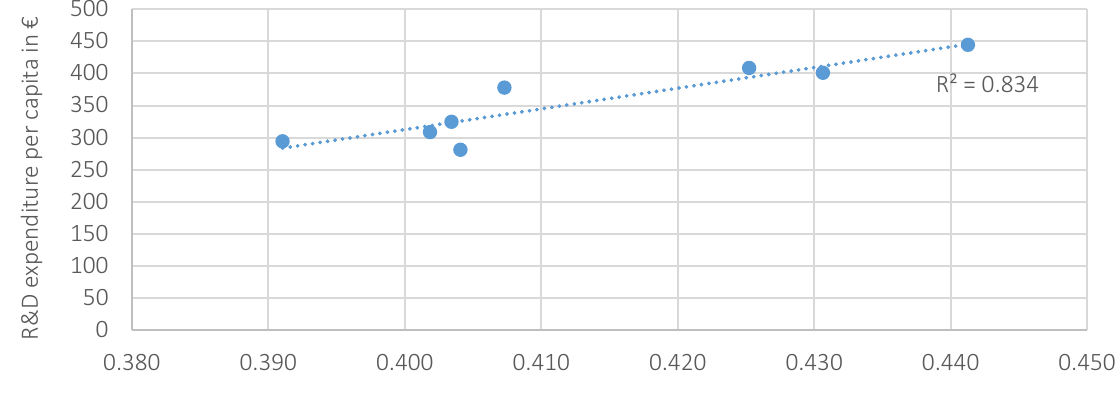
Figure 3. Correlation analysis – Czechia